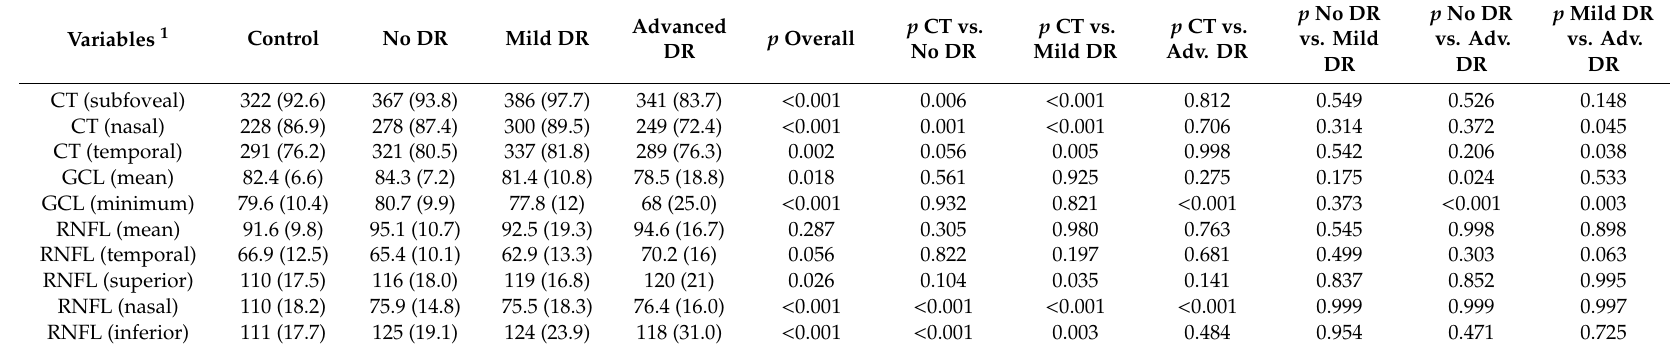
Table 2. Association between diabetic retinopathy grade and ophthalmological